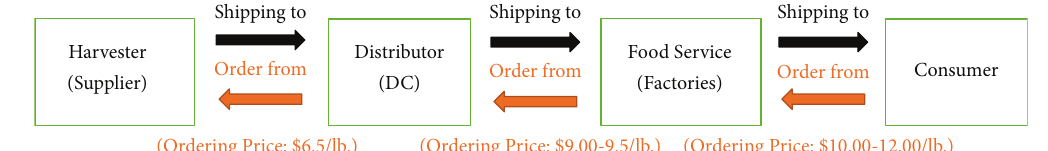
Figure 2: Product and price flows. Note: the figure is adapted from direct marketing of Cape Breton lobster and its impact on the triple bottom line of fishery performance (p 17 of [28]).